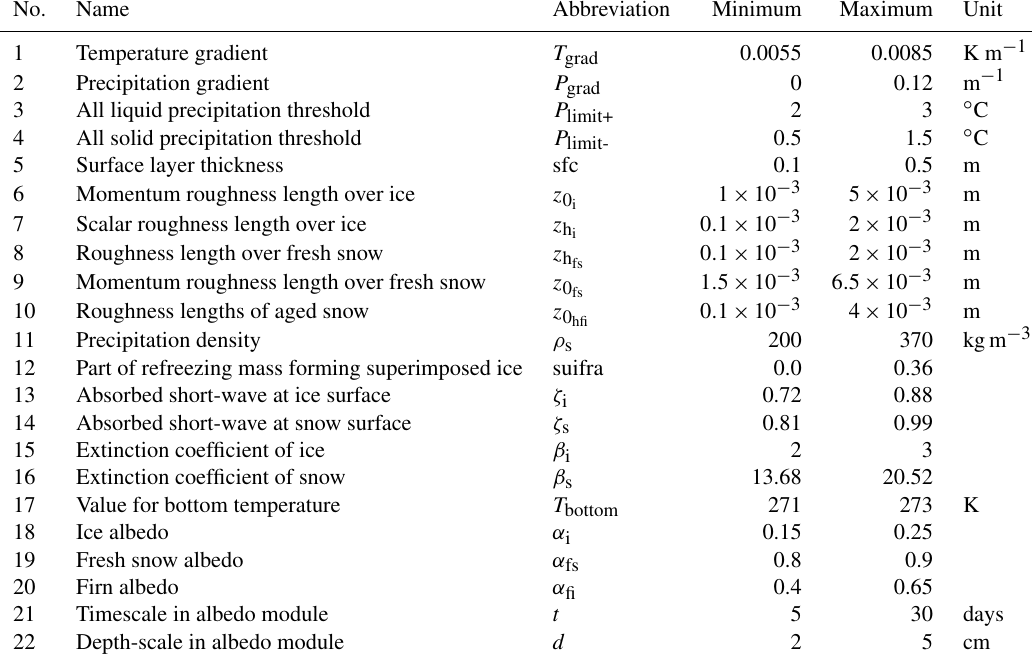
Table 2. The ranges for the 22 different parameters used in the sensitivity study. Most parameterizations are explained in the Appendix A.